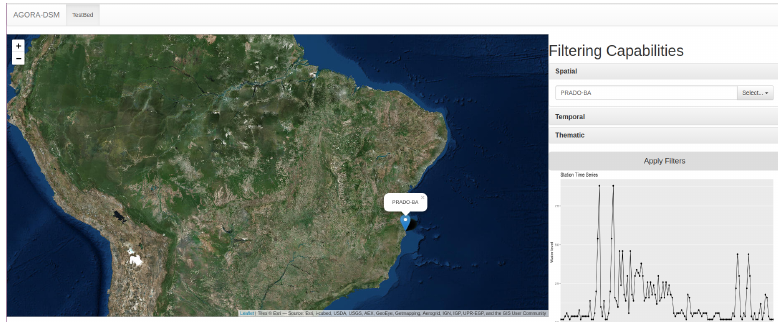
Figure 24. Prototyping Web App—Result Filtering